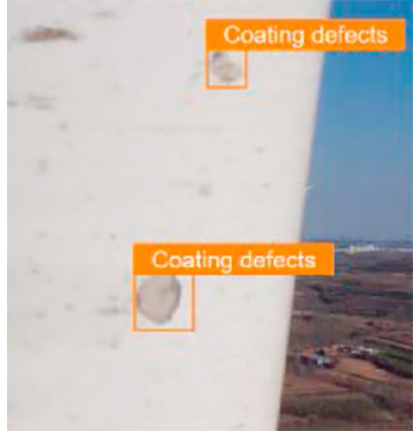
Figure 5. Photo of the blade coating defects [33].